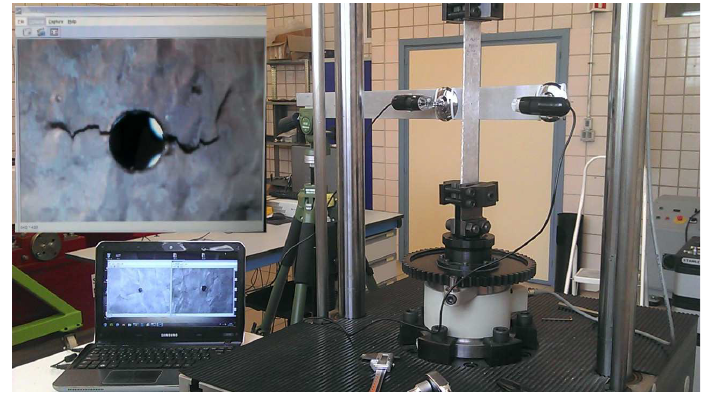
Figure 2: Crack Follow up Set